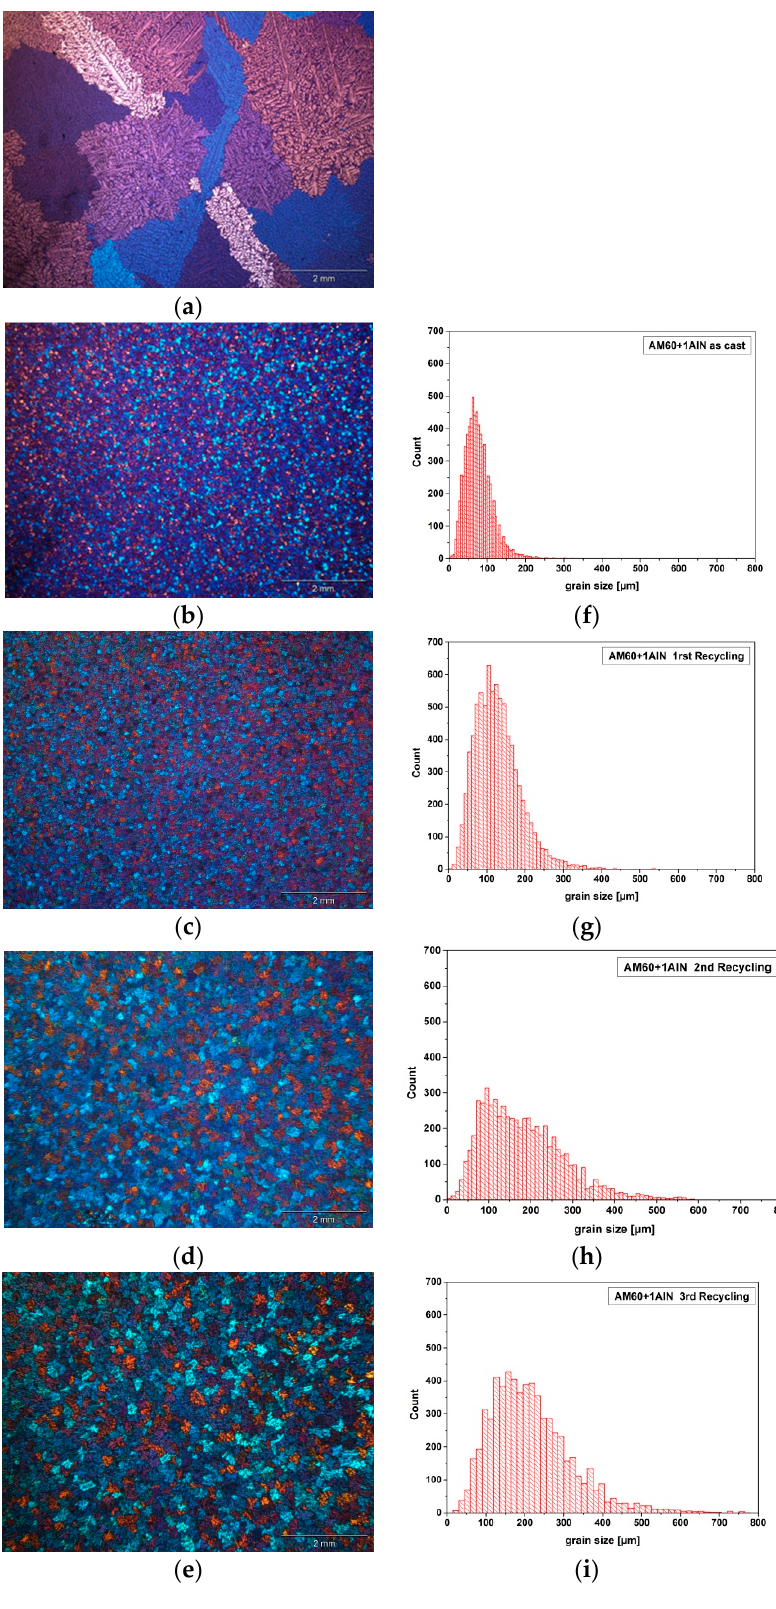
Figure 3. Microstructures of ( a ) AM60 and ( b ) AM60 + AlN. Microstructures of the first, second, and third recycled castings are shown in ( c – e ), respectively. Grain size distributions of ( b – e ) are presented in ( f – i ), respectively.